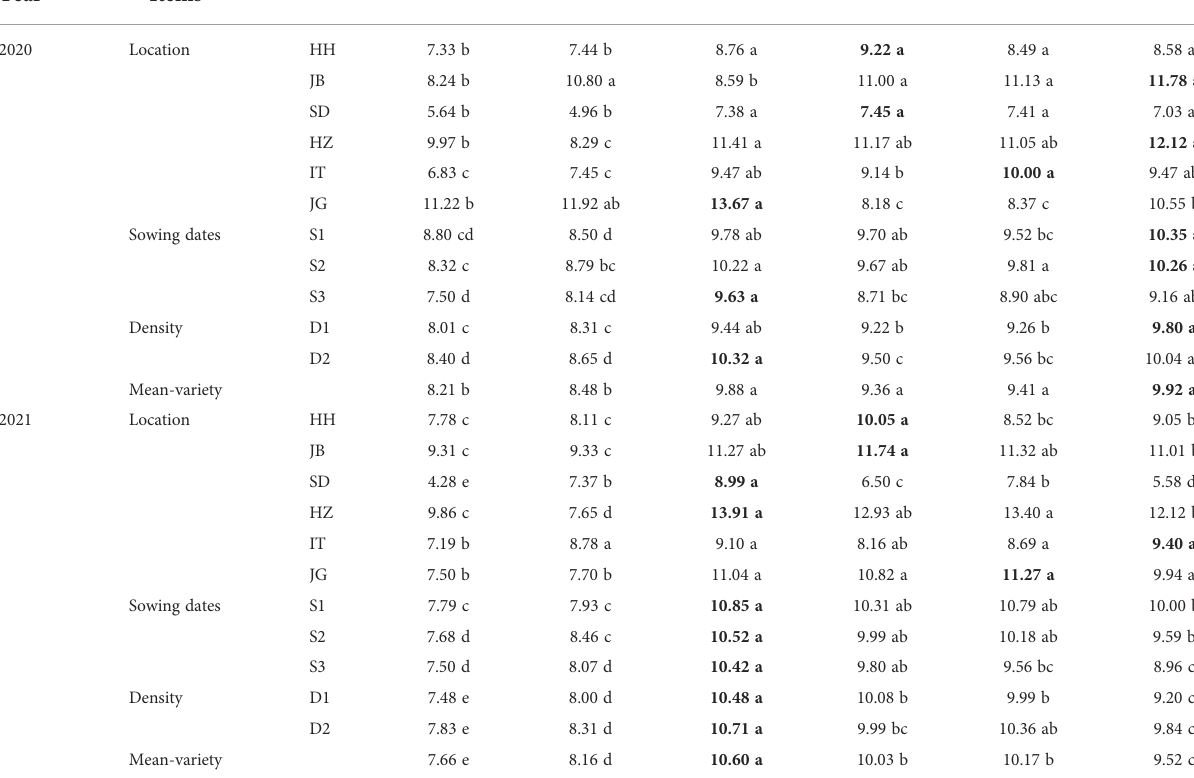
TABLE 3 Yield performance of six varieties under different sowing dates and dates at six locations in